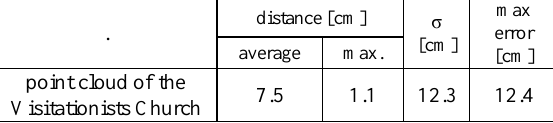
Table 5. Results of accuracy assessment of point clouds of the Visitationists Church in Warsaw generated from video frames with reference to TLS